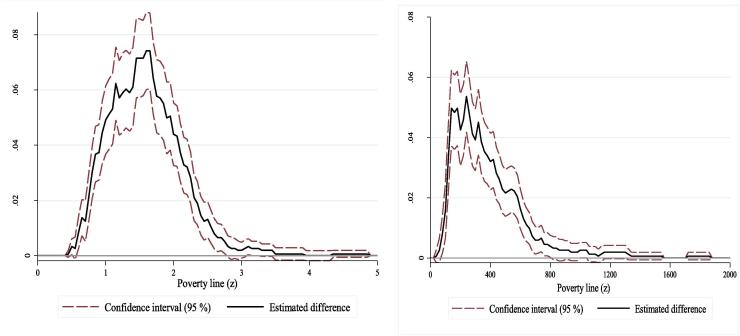
Observed and counterfactual income and asset ownership distribution differences.